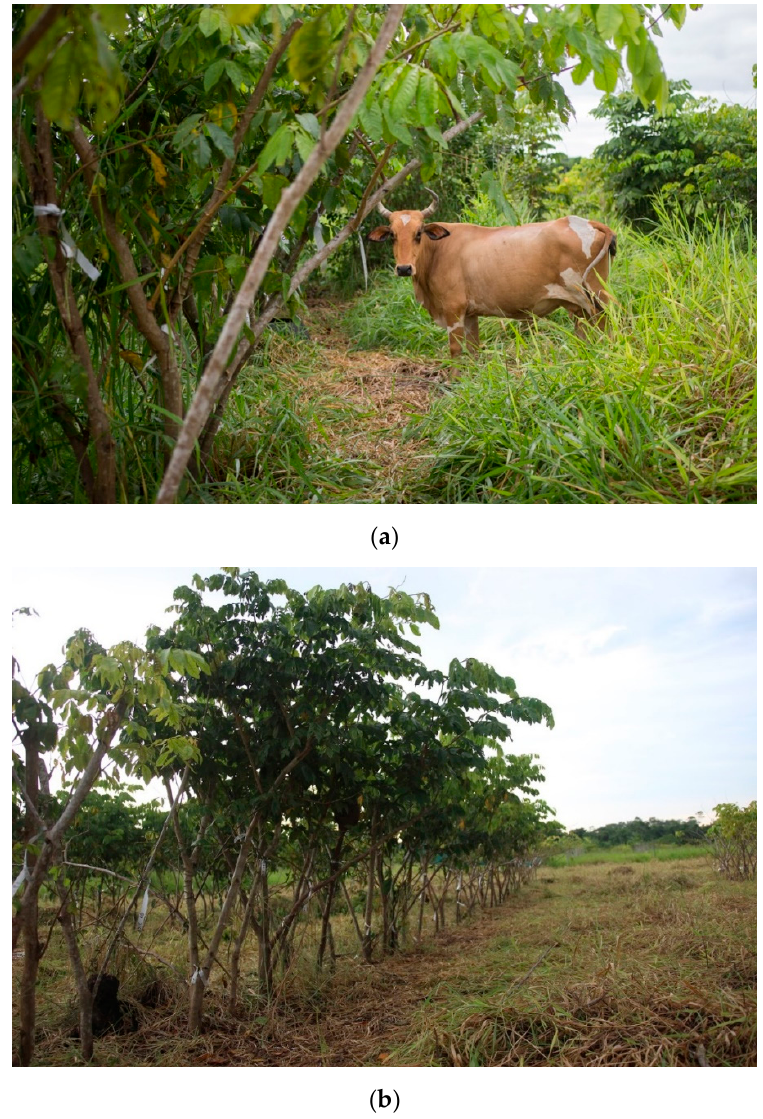
Figure 4. A photo taken from the same position of an I. edulis replicate on the first ( a ) and eighth ( b ) day of the cattle trial.